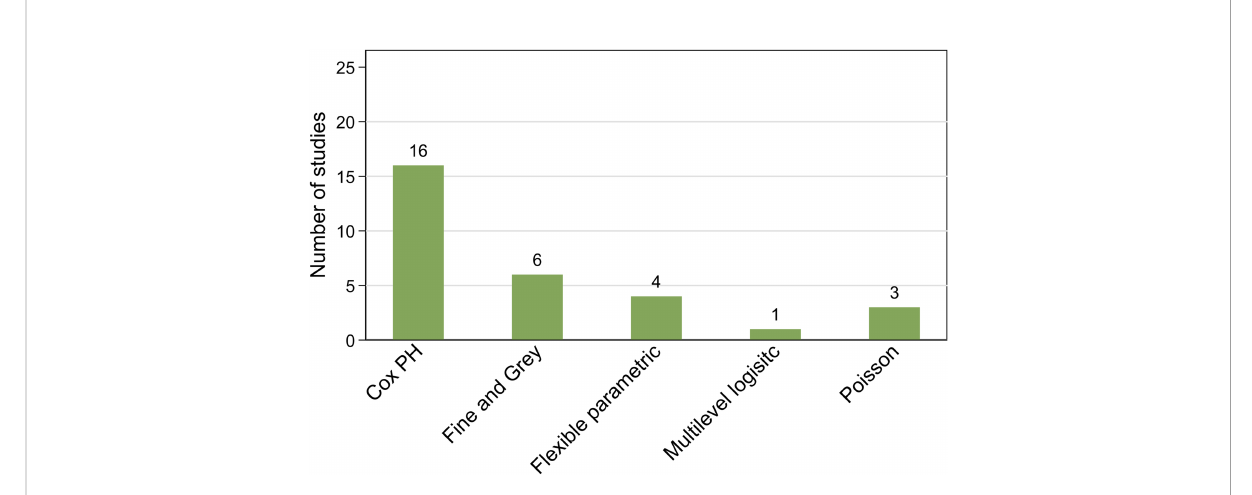
FIGURE 3 Summary of included studies by statistical